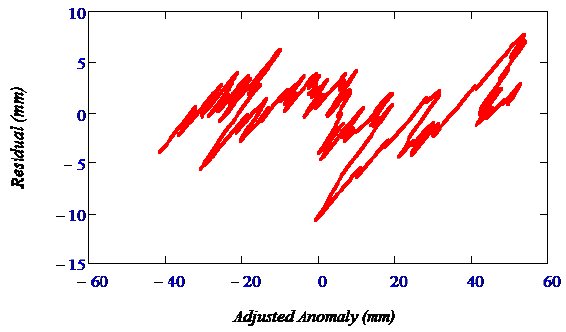
Fig. 3. AR(1) residuals are plotted against the adjusted anoma- lies. They reveal unpredictable bursts, caused by random schocks/innovations, over time.